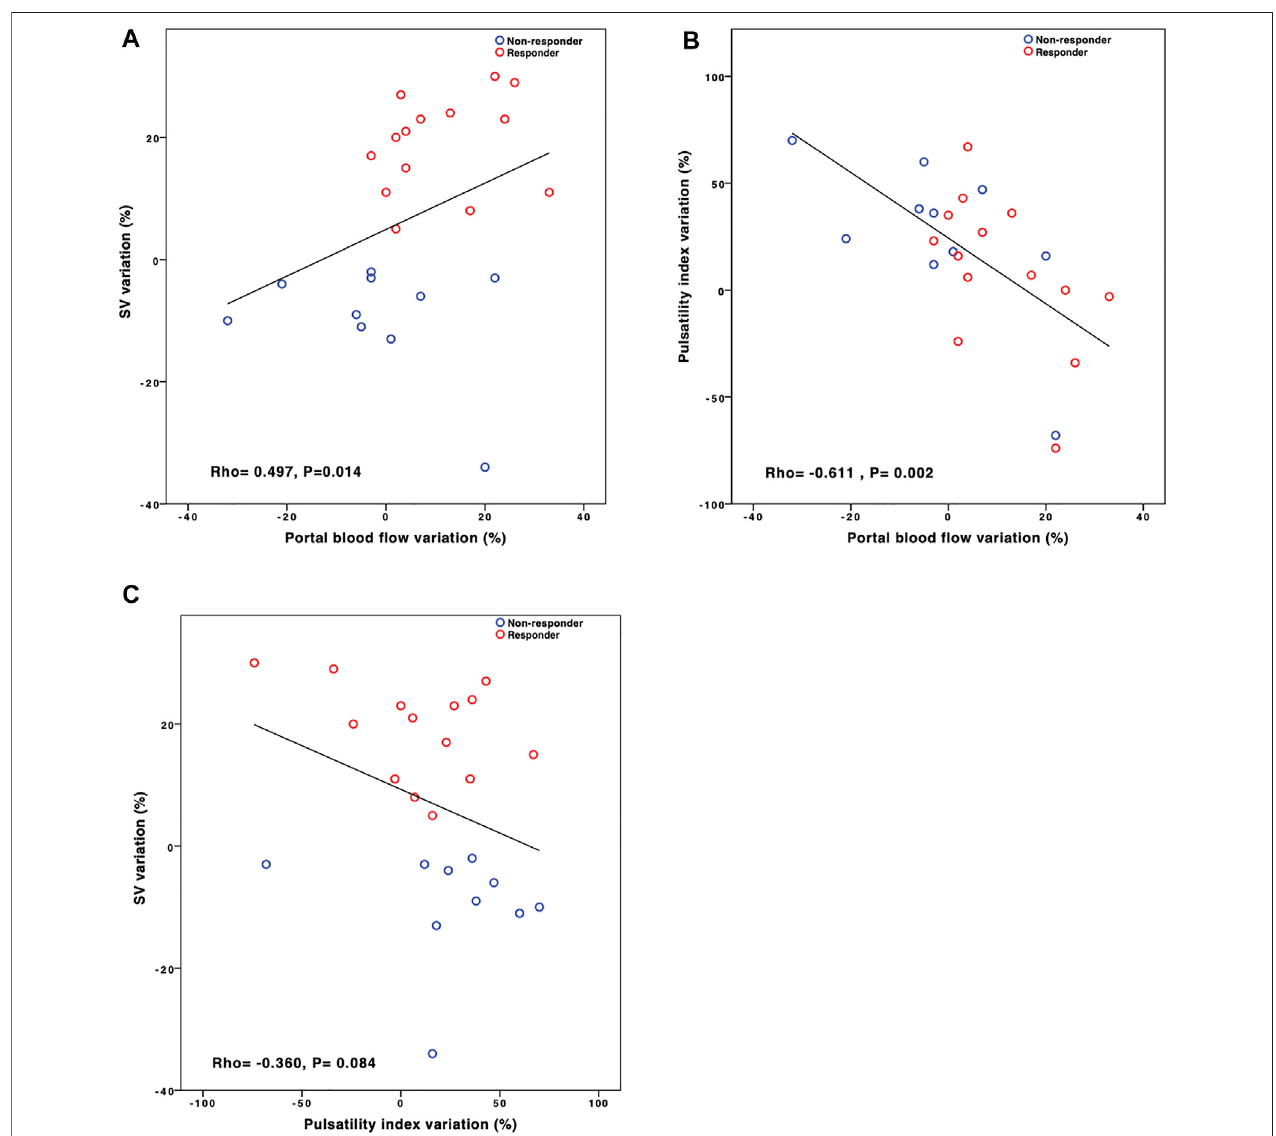
FIGURE 3 | Relationships between the stroke volume (SV), pulsatility index, and portal blood fl ow variations induced by the fl uid challenge (FC). Fluid responsiveness wasde fi ned by a greater than 10% increasein SV. Variation was calculated for each variable as 100 p (post-FC value-baselinevalue)/post-FC value. Red plots: responder. Blue plot: non-responder. Correlations were tested using Spearman ’ s correlation test.